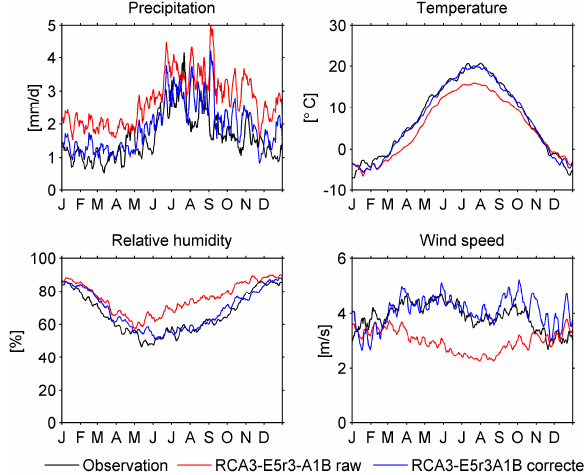
Figure 4. Seasonal variation of the FWI inputs (precipitation, tem- perature, relative humidity and wind speed) presented as 7-day moving average values at the Edsbyn station (see Fig. 1). Compar- ison of observational data, raw output of the climate models from RCA3-E5r3-A1B simulation and its corresponding corrected output (validation period